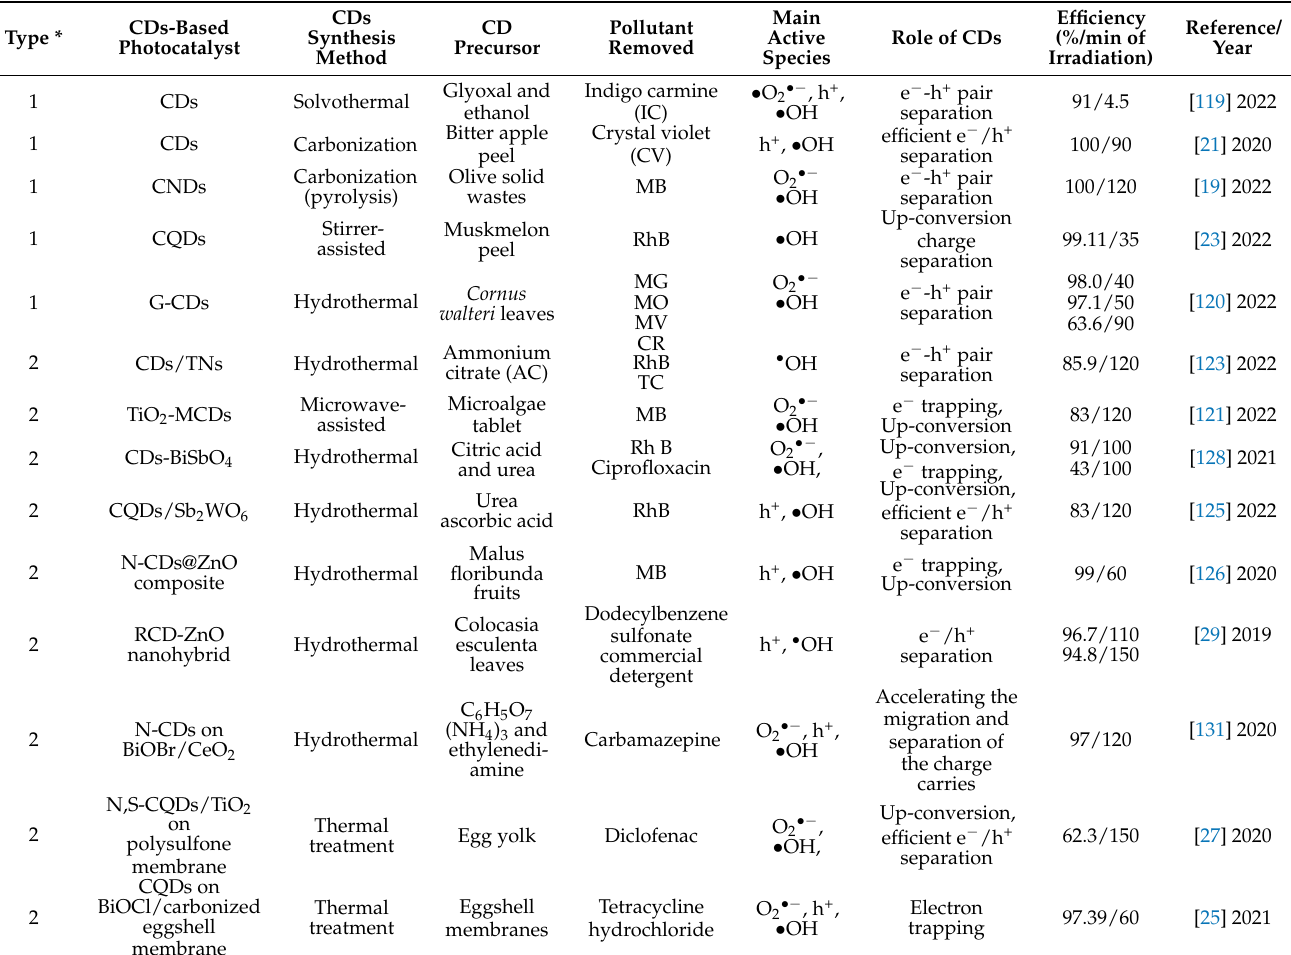
Table 1. Precursors, synthesis methods, target pollutants, active species, degradation efficiencies, and roles of CDs for the removal of various organic